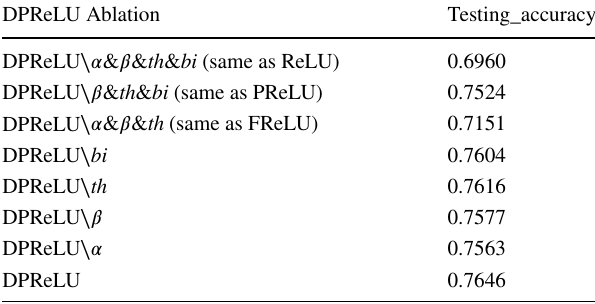
Table 5 Testing accuracy of the ResNet50 models with DPReLU activation and different weight initialization on CIFAR-10